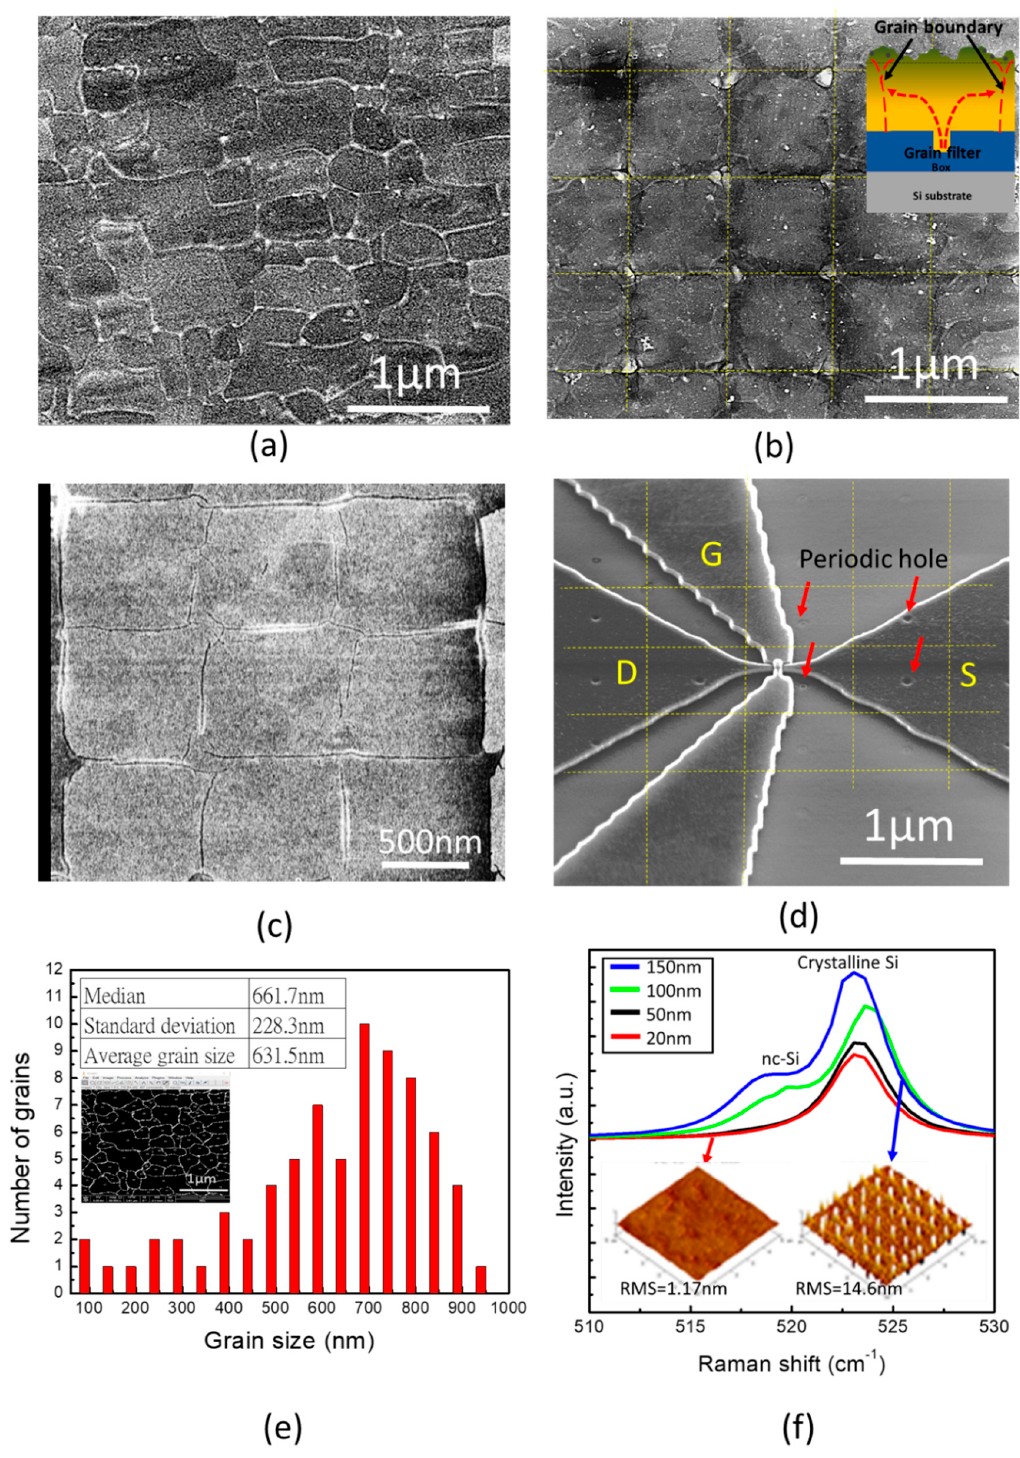
Figure 3. ( a ) SEM image of random grain growth poly-Si channel; ( b ) SEM image of a Si matrix using the LCG technique with the grain filter illustrated in the inset; ( c ) SEM image of a thin LCG Si film after CMP and SEECO etch (solution of K 2 Cr 2 O 7 water mixed with HF) to reveal the grain boundaries; ( d ) SEM image of a single grain GAA Si NW FET intentionally located in a Si gain; ( e ) grain size distribution of a Si channel without the LCG technique and the inset is the image analysis conducted by the ImageJ software. ( f ) The Raman spectrums of the Si channel before and after the CMP thinning process and inset AFM images show the related surface morphology and the root mean square roughness.